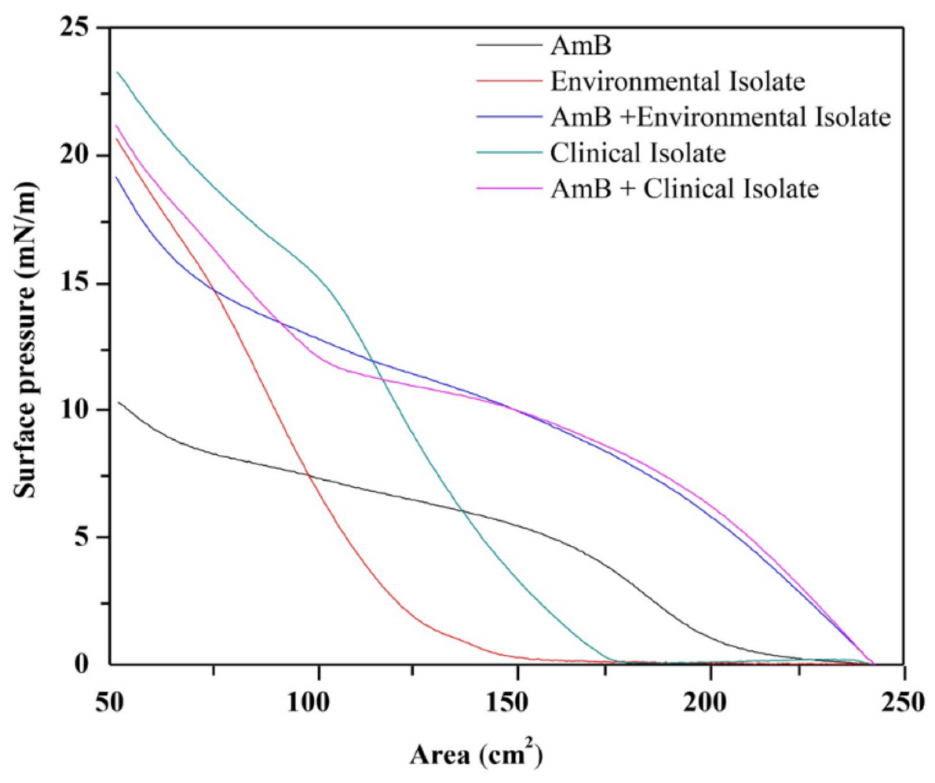
Figure 5. Surface pressure-area isotherms from the AmB monolayers trough (50 µ L); lipids extracts associated to the external surface of the cell wall of the mycelial phase of H. capsulatum of the environmental (5 µ L) and clinical (5 µ L) isolates; mixture of AmB (50 µ L) with lipid extract (5 µ